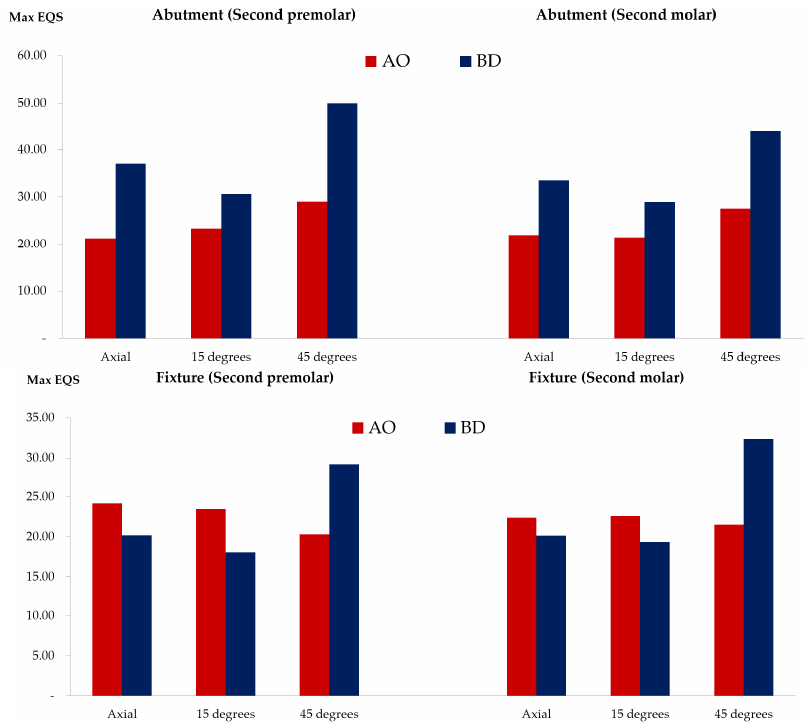
Figure 9. Mean stress distribution of the outer surface of the abutment and fixture in the second premolar and second molar.